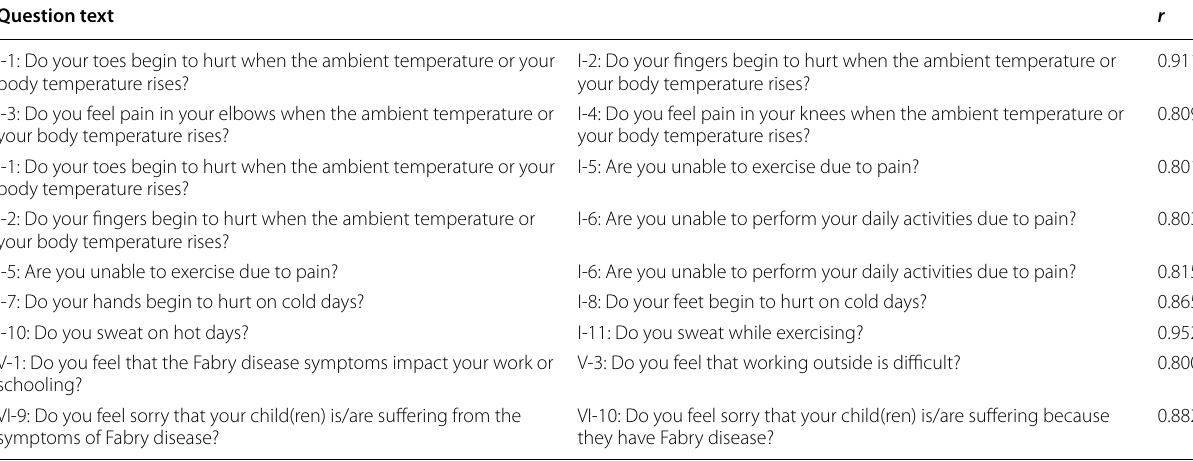
Table 1 High item-item correlation pairs (Pearson’s correlations; N